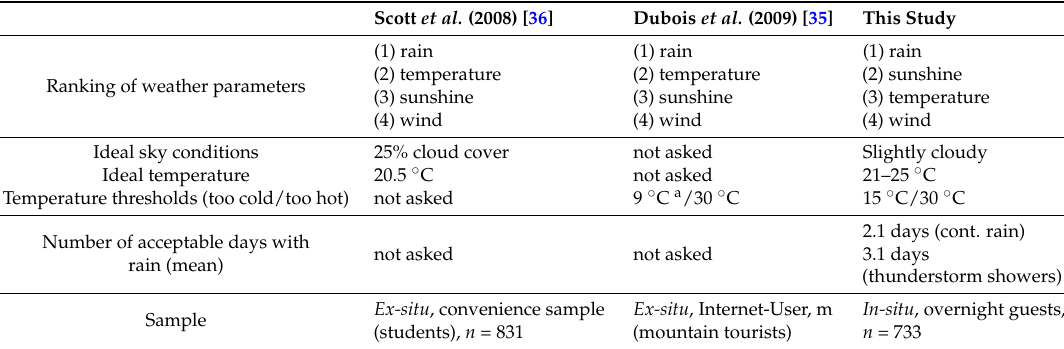
Table 4. Main results compared to other mountain tourism